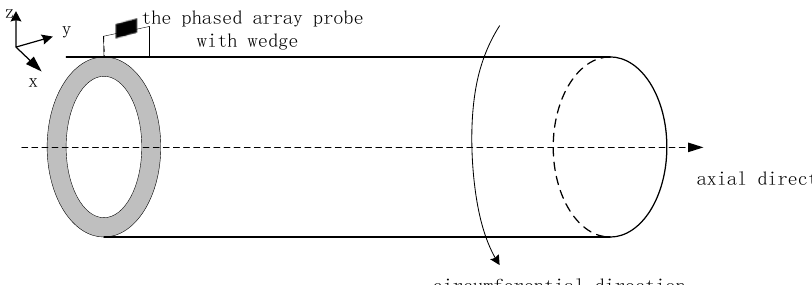
Figure 1. Schematic diagram of the scanning tube material path with phased-array ultrasonic transducer, with the transducer placed on the convex circular tube interface.